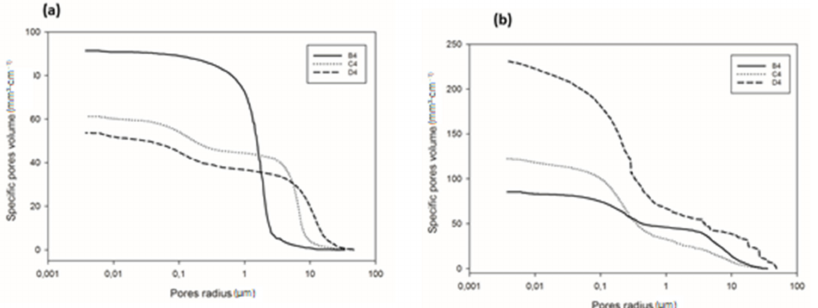
Figure 9. Cumulative pore volume of the cold-setting refractory composites: ( a ) at 1200 °C and ( b ) at 1250 °C.